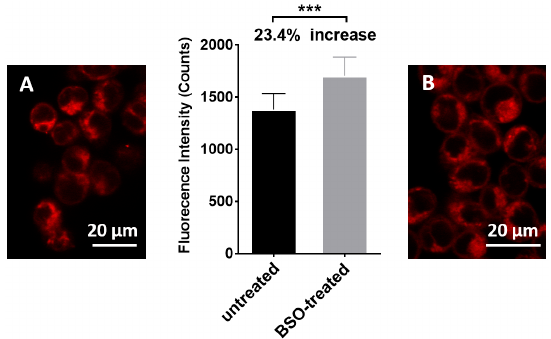
Figure 9. Relative fluorescence intensity of untreated cells and BSO treated cells. The fluorescence of nine small random areas in a cell image were measured for each treatment using ImageJ Fiji. Unpaired student t -test was used with p < 0.05 (***). ( A ): confocal microscopic image of HEK293 cells incubated with 1 ; ( B ): confocal microscopic image of HEK293 cells pre-treated with BSO and incubated with 1 .